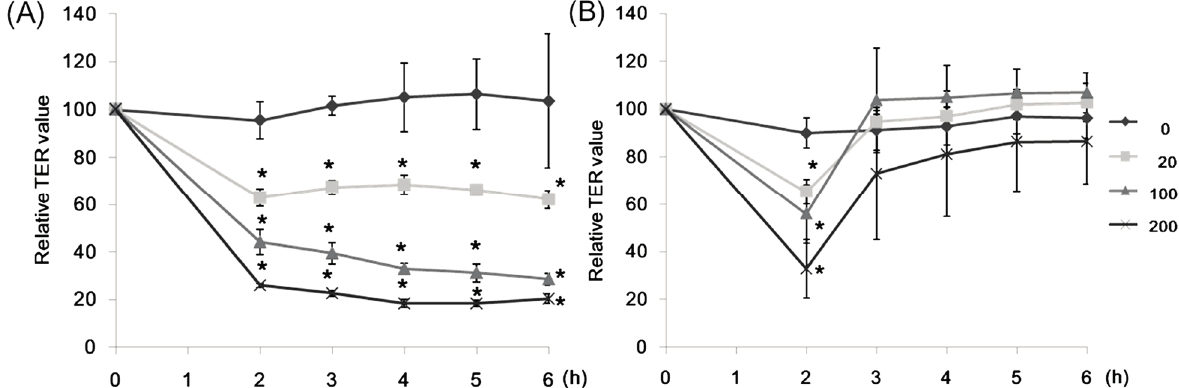
Figure 2. Effects of CSL3 on TER values of Caco-2 cell monolayers. ( A ) The cell monolayers were incubated with CSL3 (20–200 µg/mL) for 6 h. TER values were measured periodically during incubation. ( B ) The cell monolayers were incubated with CSL3 (20–200 µg/mL). After incubation with CSL3 for 2 h, 10 mM L -rhamnose were added to the apical side. Results are shown as a percentage of the control (without lectins) values, and are the means ± SD of three different determinations. * p < 0.05 compared with the control value at 2 h.